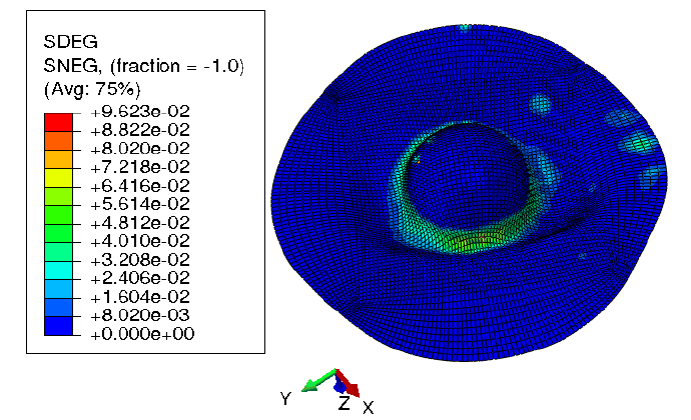
Figure 21. 3D isovalues of stiffness degradation determined by finite-element simulation for multi- step forming.